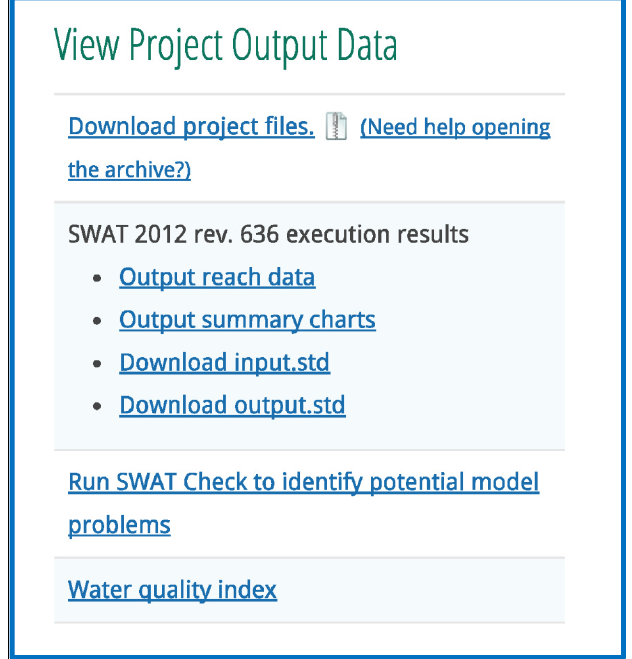
Figure 6. Output demonstration: (i) output reach data; (ii) output summary charts; (iii) download